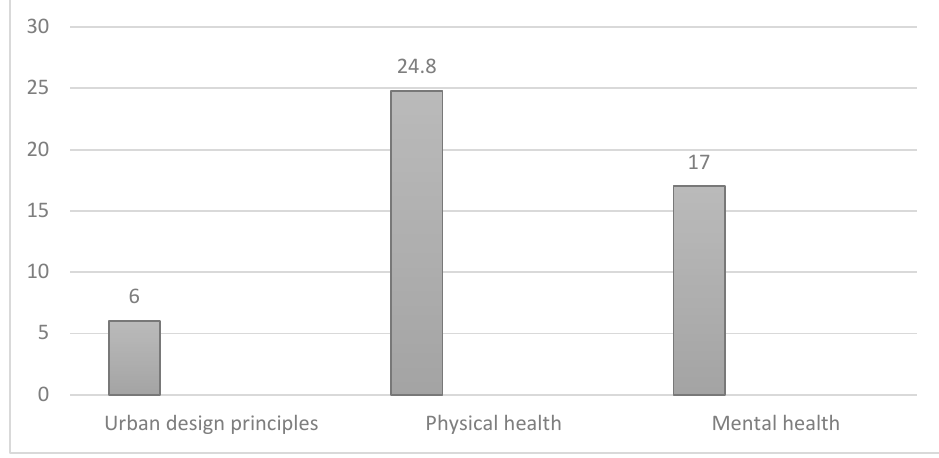
Figure 2. Boxplot of descriptive indices of variables.